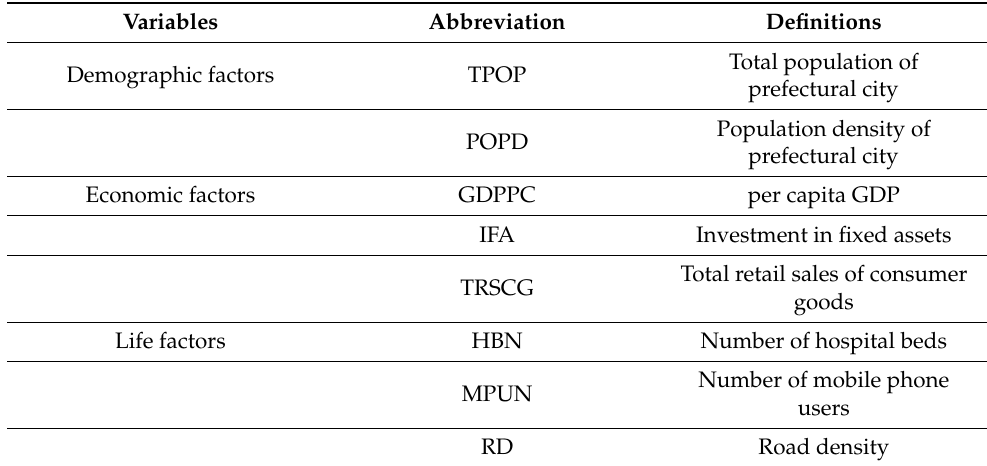
Table 4. Socioeconomic variables considered in this